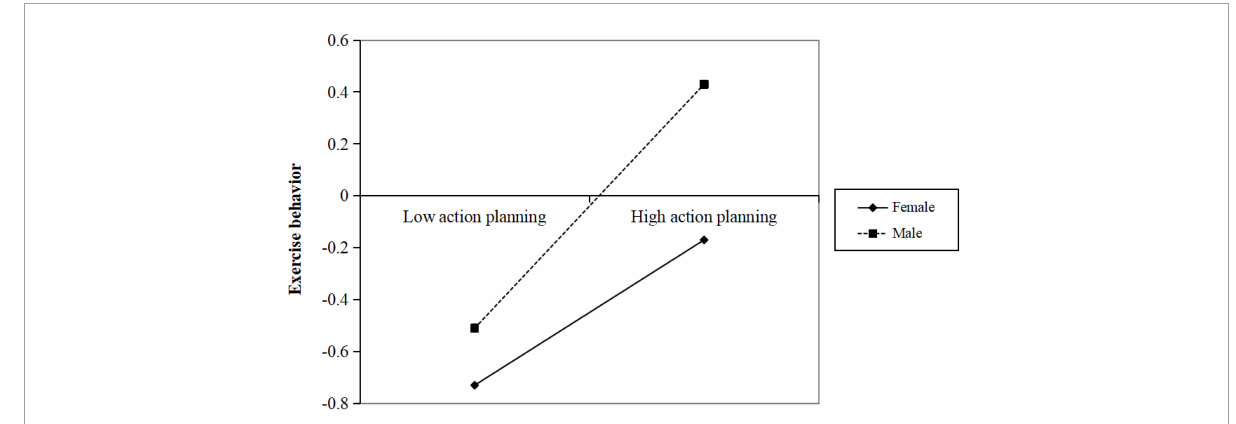
FIGURE3 Gender moderated the relationship between action planning and exercise